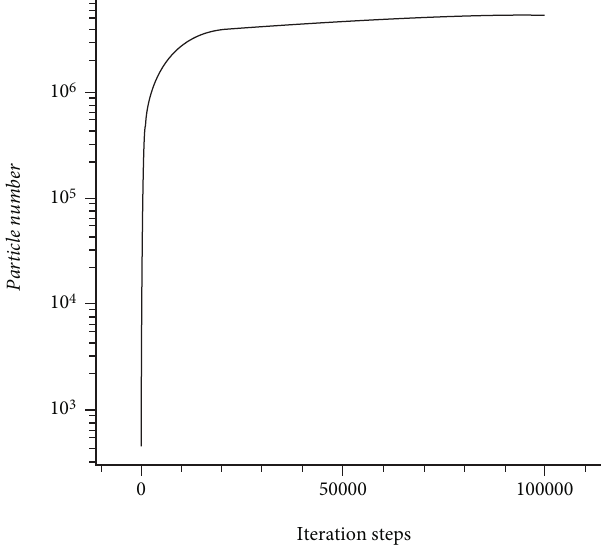
Table 4: The reference parameters and the value.